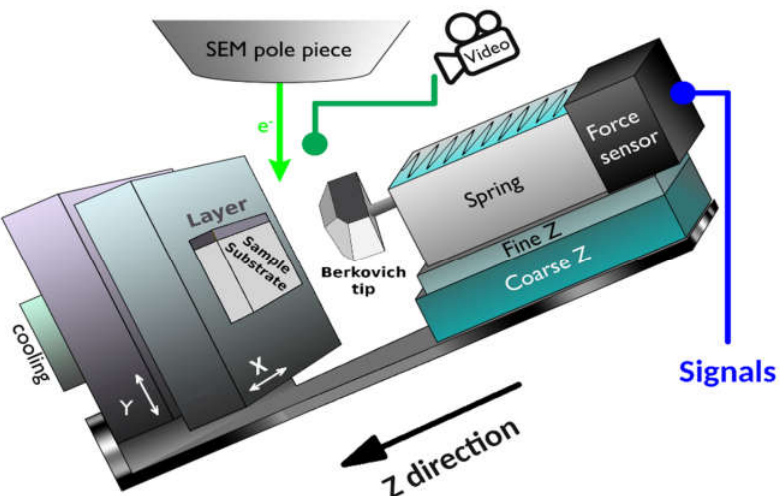
Figure 3. 3D image of in situ nanoindenter .